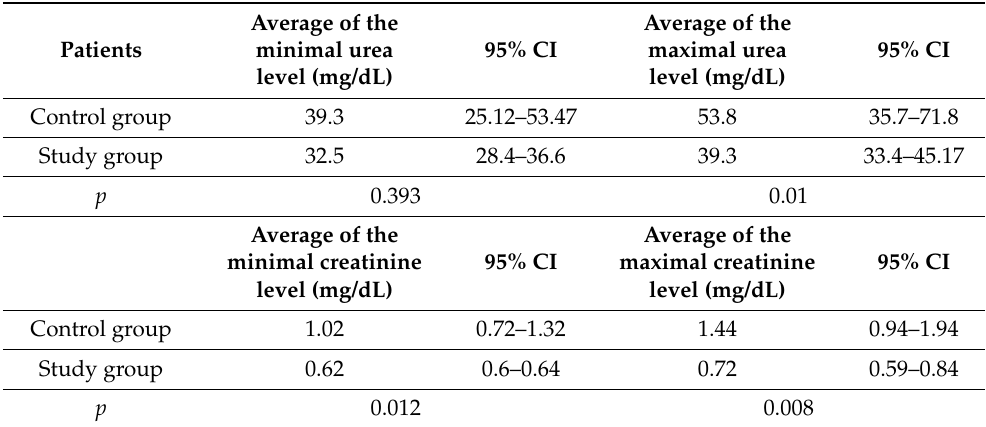
Table 4. Variability of kidney function parameters between groups.